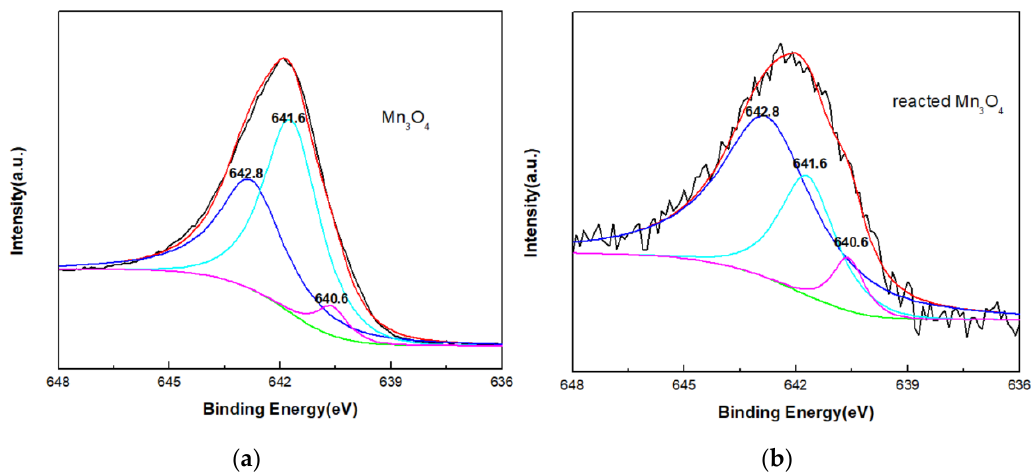
Figure 9. Mn 2p spectra XPS of Mn 3 O 4 before and after reaction with phenol ( a ) prepared Mn 3 O 4 ; ( b ) reacted Mn 3 O 4 .